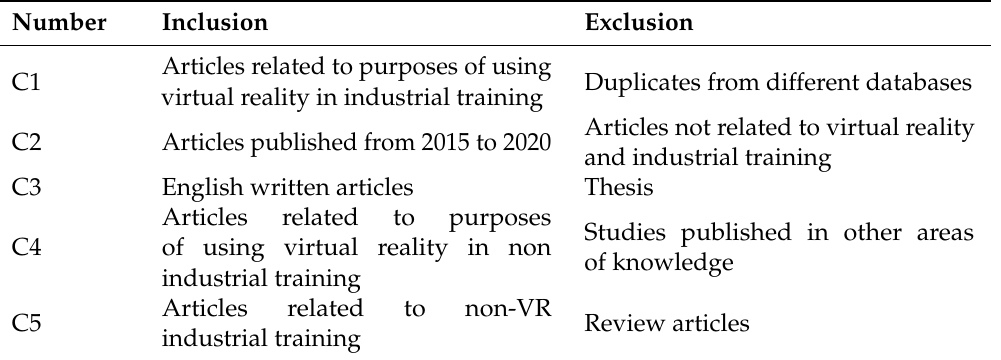
Table 2. Inclusion and exclusion